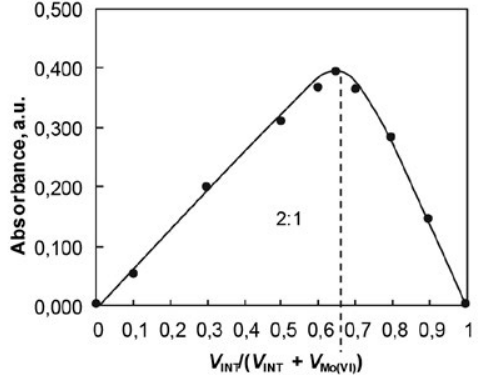
Figure 5. Determination of the molar ratio (n) Mo(VI):INT by the method of continuous variations C + C = 8.0 × 10 −5 M; C Mo(VI) INT C